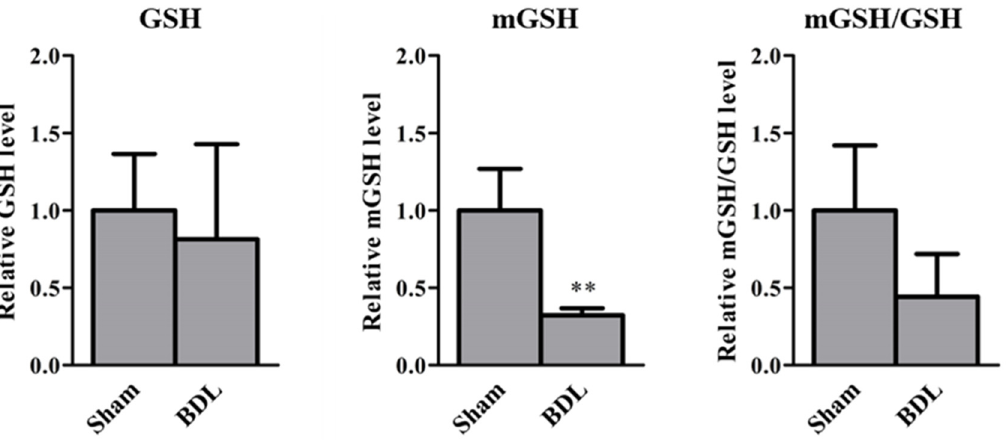
Figure 5. Relative glutathione (GSH), mitochondrial GSH (mGSH), and mGSH/GSH levels in the kidneys of sham and bile duct ligation (BDL) mice. The results are expressed as the mean ± S.D. of each group (n = 3 − 4). Signi fi cant di ff erences (** p < 0.01) between sham and BDL mice were observed.